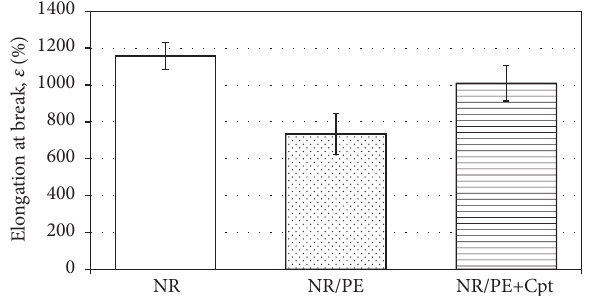
Figure 5: Elongation at break of neat NR, NR/PE blend, and NR/PE blend treated with